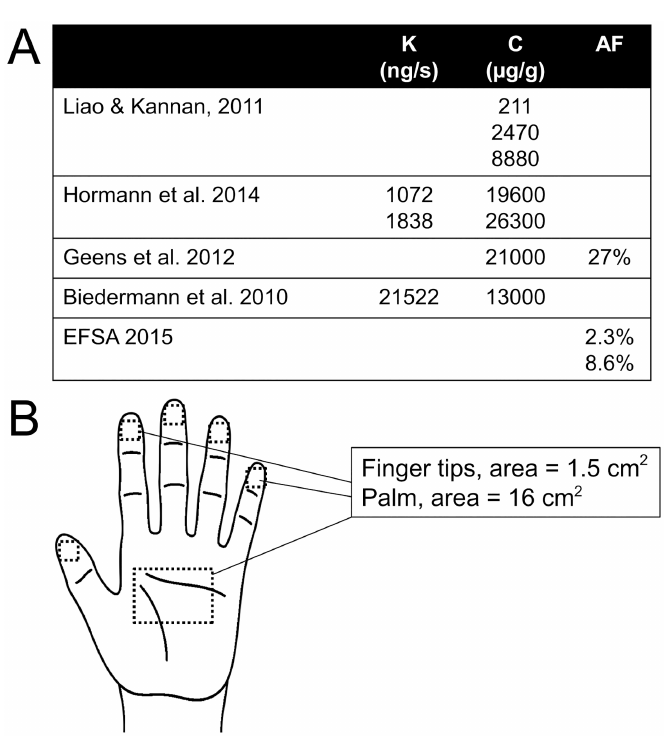
Fig 3. Factors and features that influence estimated intake. A) Summaries of transfer coefficients(k), concentrations (c) and absorptionfactors (AF) reportedin prior studies. B) Conservative estimates of the surface area in contact with thermal paper held by fingertips or in the